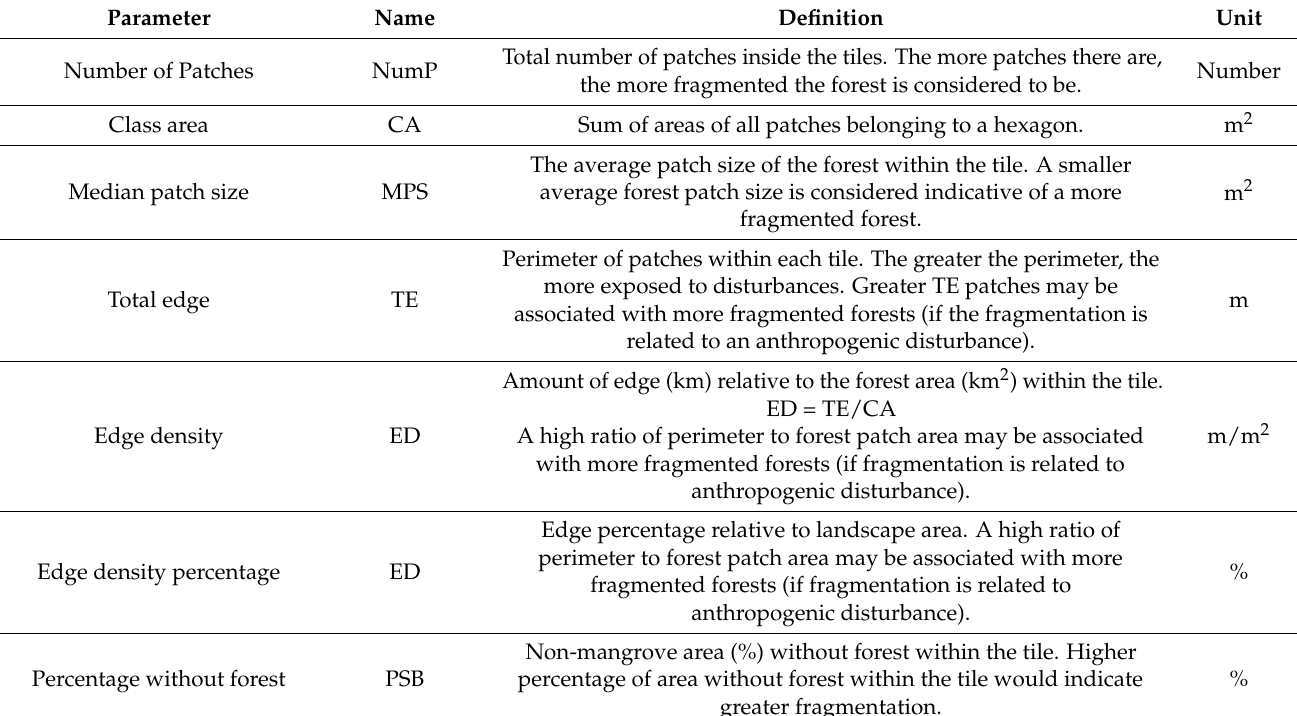
Table 1. Description of the fragmentation metrics